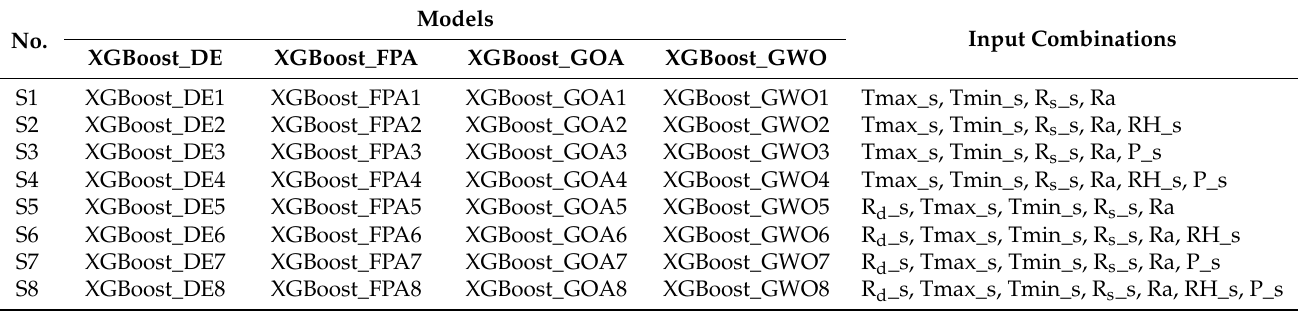
Table 2. The input combinations based on satellite data for four coupling models.